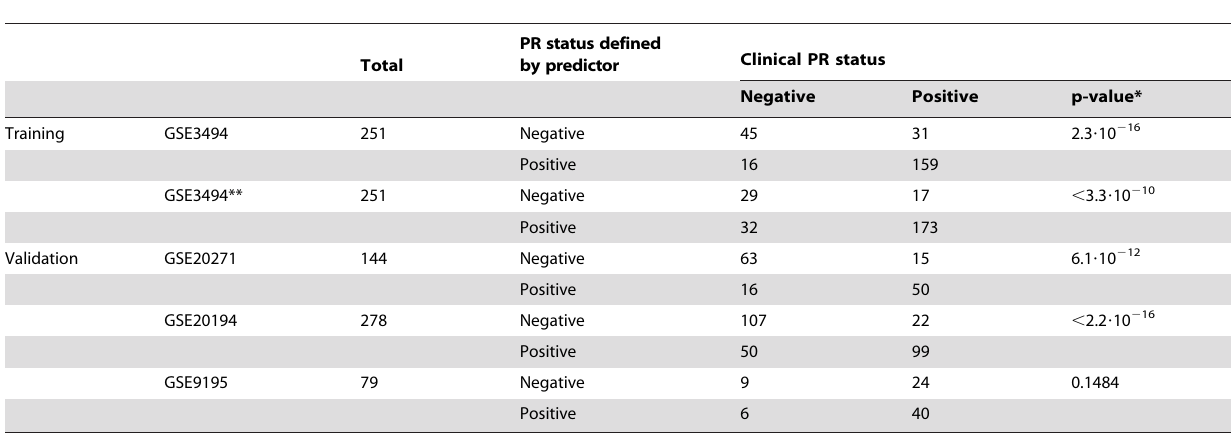
Table 6. Correlation of microarray–based expression profiling data with routinely established PR status.